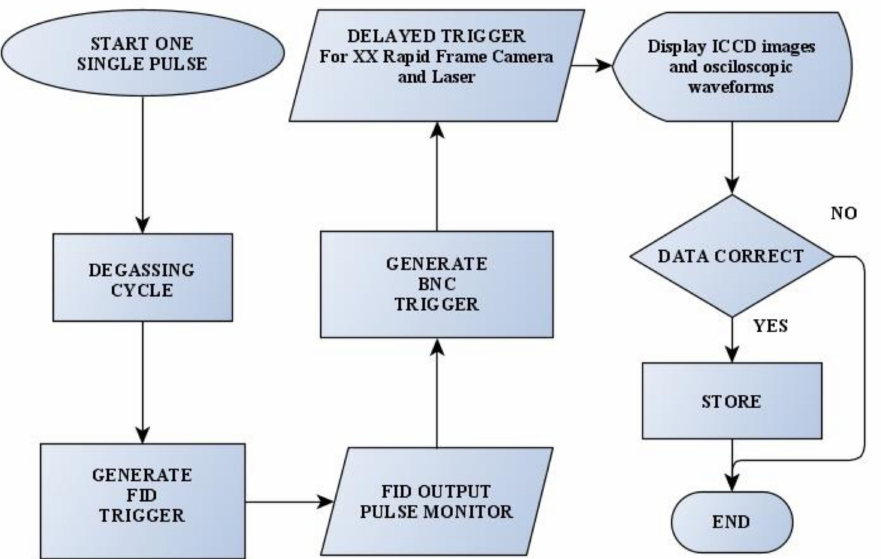
Figure 3. Flowchart of the LabVIEW VI programme that controls the performance of a complete discharge cycle with subsequent data acquisition and